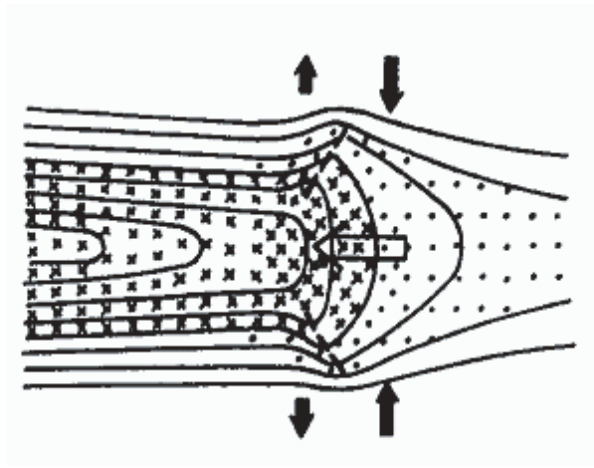
Fig. 10. Configuration of NFTE structure consistent with their ob- served signatures. (From Sergeev et al., 1992).